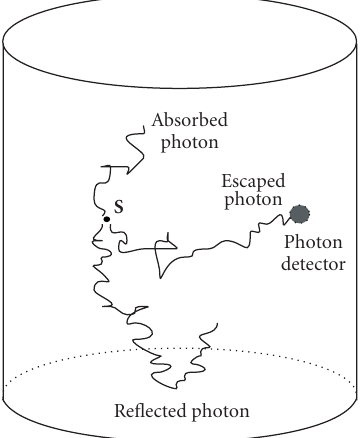
Figure 1: The Monte Carlo process of photon propagation in tissue.